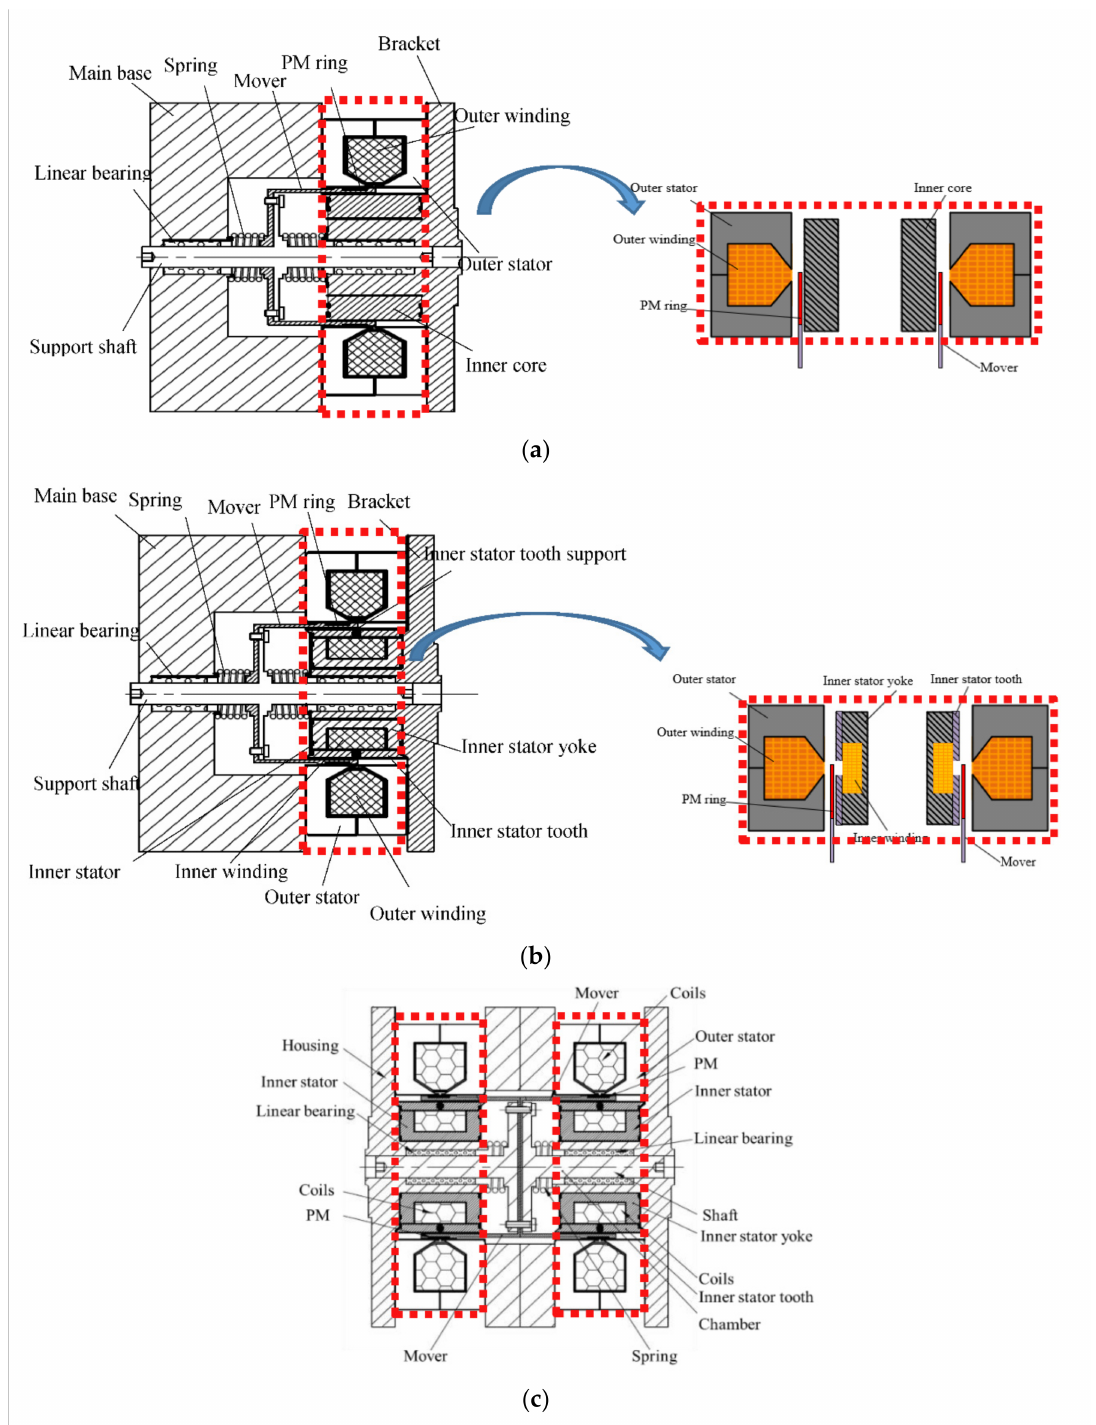
Figure 1. Discussed models: ( a ) Conventional model 1 without inner stator winding; ( b ) Proposed model 2 with inner stator winding; ( c ) Proposed model 3 as two modular model